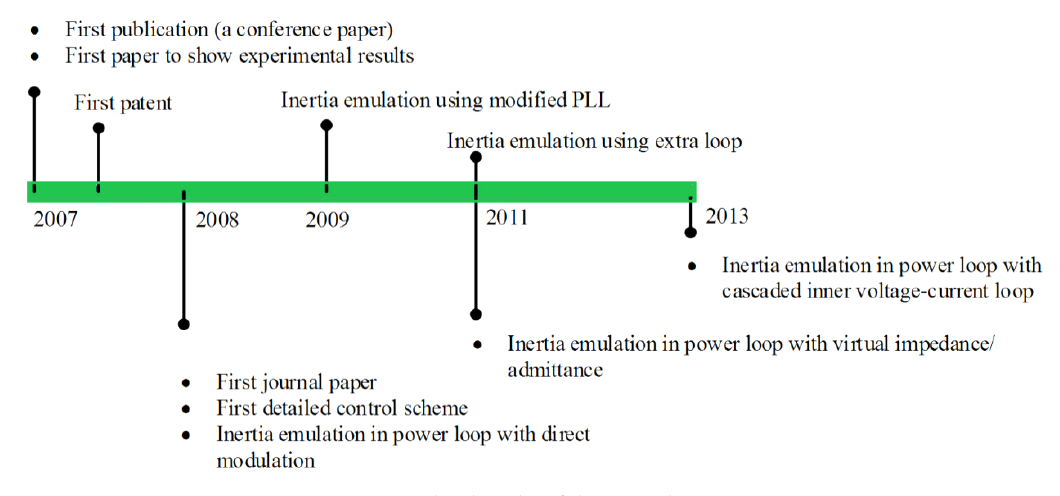
Figure 9. Important landmarks of the virtual inertia concept.